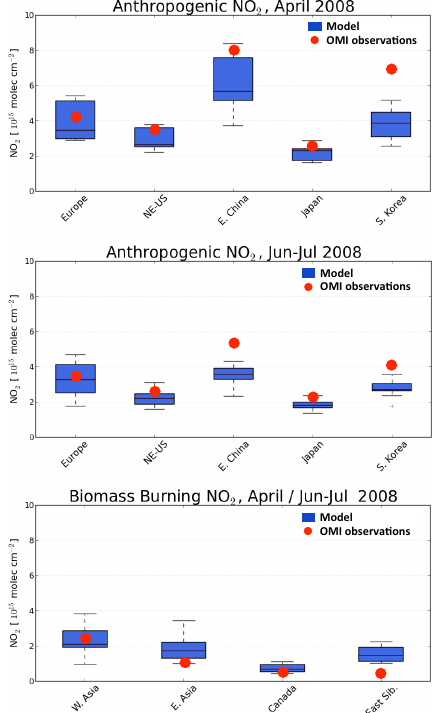
Figure 14. Summary of the regional means from each model and the OMI NO 2 tropospheric columns for each region indicated in Fig. 13. (top) Anthropogenic emissions in April and (middle) June– July, (bottom) biomass burning in both seasons. Red circles are mean OMI NO 2 observations for the region; box plots show me- dian, 25th and 75th quartiles, whiskers to 5th and 95th percentiles of the model